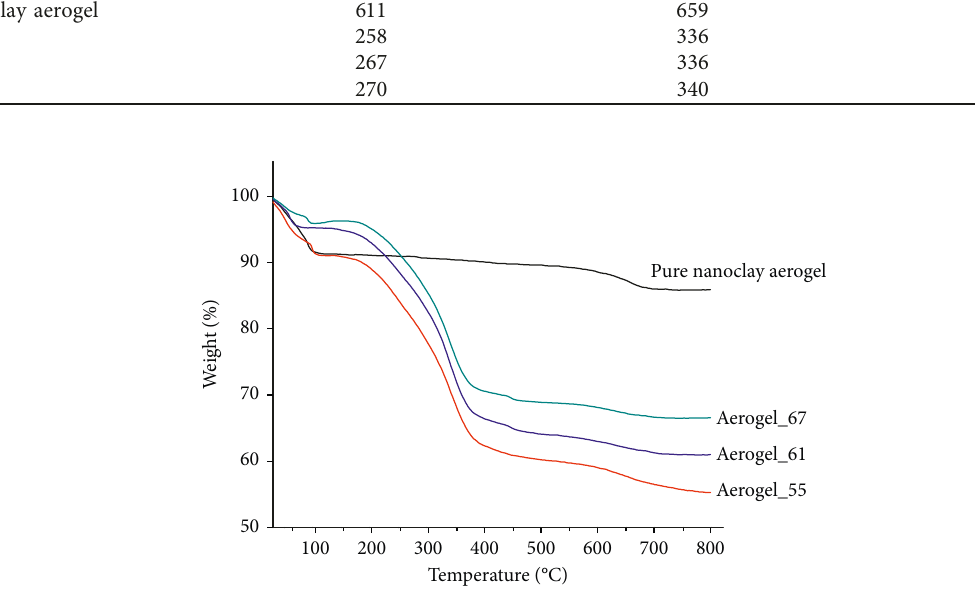
Figure 5: TGA thermogram of nanoclay aerogel masterbatches.